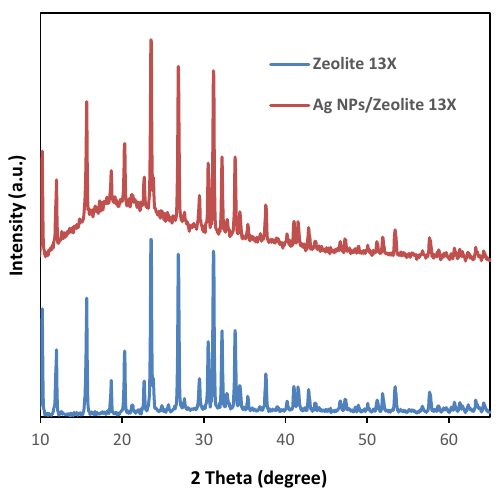
Fig. 5. XRD pattern of the Zeolite 13X and Ag NPs/Zeolite 13X nanocomposite Fig. 5 XRD pattern of the Zeolite 13X and Ag NPs/Zeolite 13X nanocomposite samples